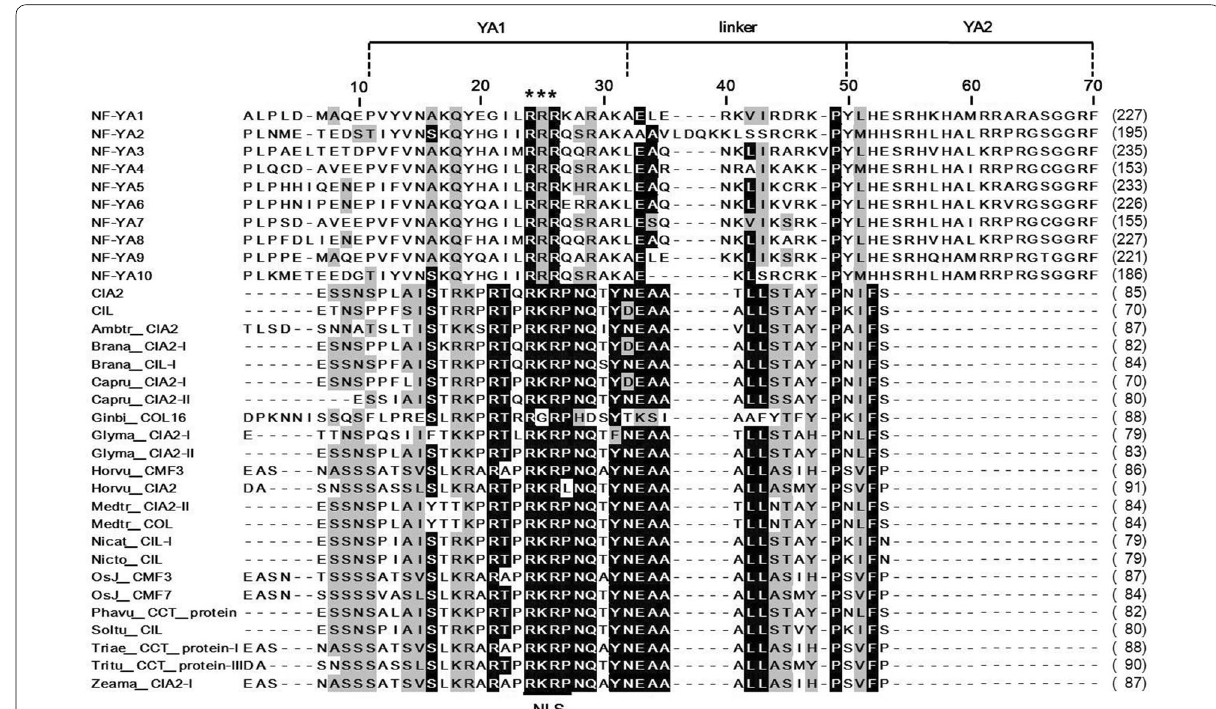
Fig. 7 Sequence alignment (using MEGA‑X software) of a conserved region of 10 Arabidopsis NF‑YA proteins and 23 CIA2/CIL homologous proteins. Numbers in brackets at the end of each sequence indicate the corresponding aa number of each protein. Numbers above the alignment represent amino acid position (in the alignment). Black and gray backgrounds represent conserved or similar residues, respectively. Residues marked with an asterisk are important in yeast NF‑YA protein. The YA1/linker/YA2 subdomain region is demarcated based on Romier et al. (2003). The location of the NLS sequence in the CC1 motifs of homologous proteins is shown below the